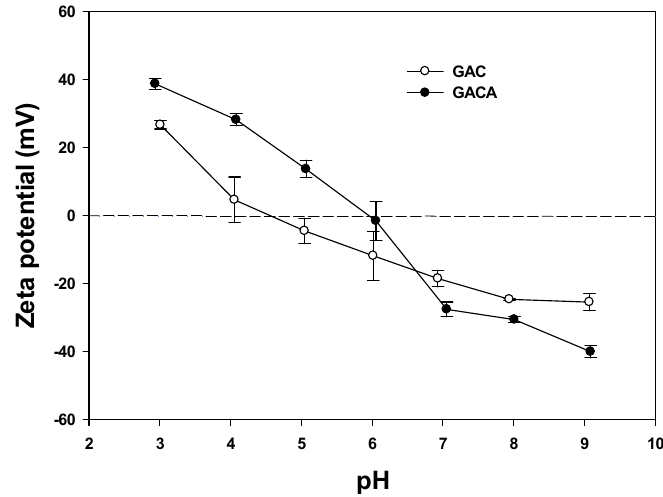
Figure 2. Zeta potential as a function of pH for GAC and GACA.